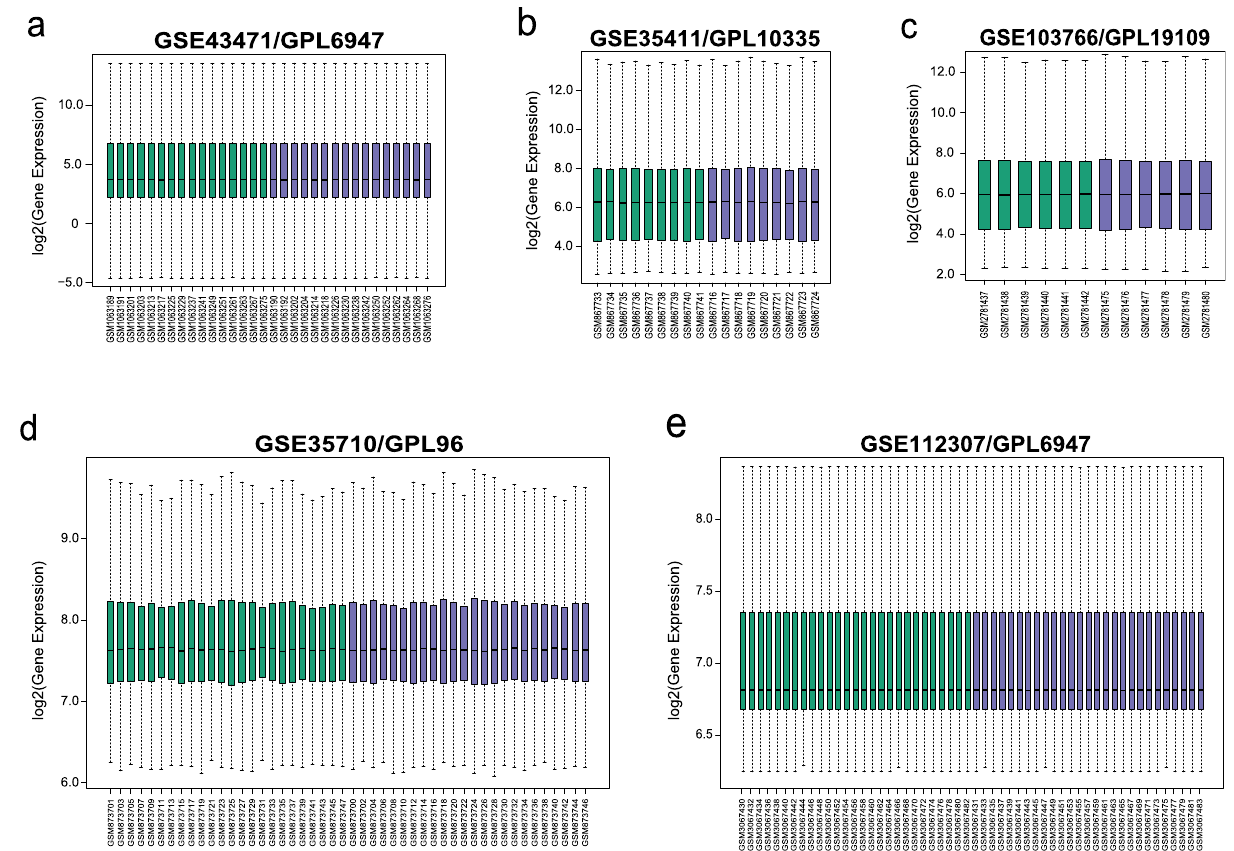
Figure 1. Box-plots of the expression profiles after consolidation and standardization. The x-axis label represents the sample symbol and the y-axis label represents gene expression values. The black line in the box-plot represents the median value of gene expression. ( a ) Standardization of GSE43471, ( b ) Standardization of GSE35411, ( c ) Standardization of GSE103766, ( d ) Standardization of GSE35710, ( e ) Standardization of